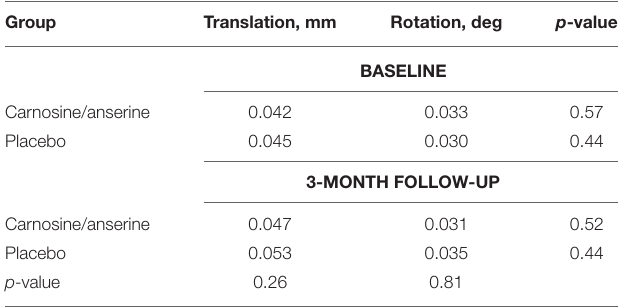
TABLE 2 | Average group head motion assessed separately for translation and rotation. Group Translation, mm Rotation, deg p -value